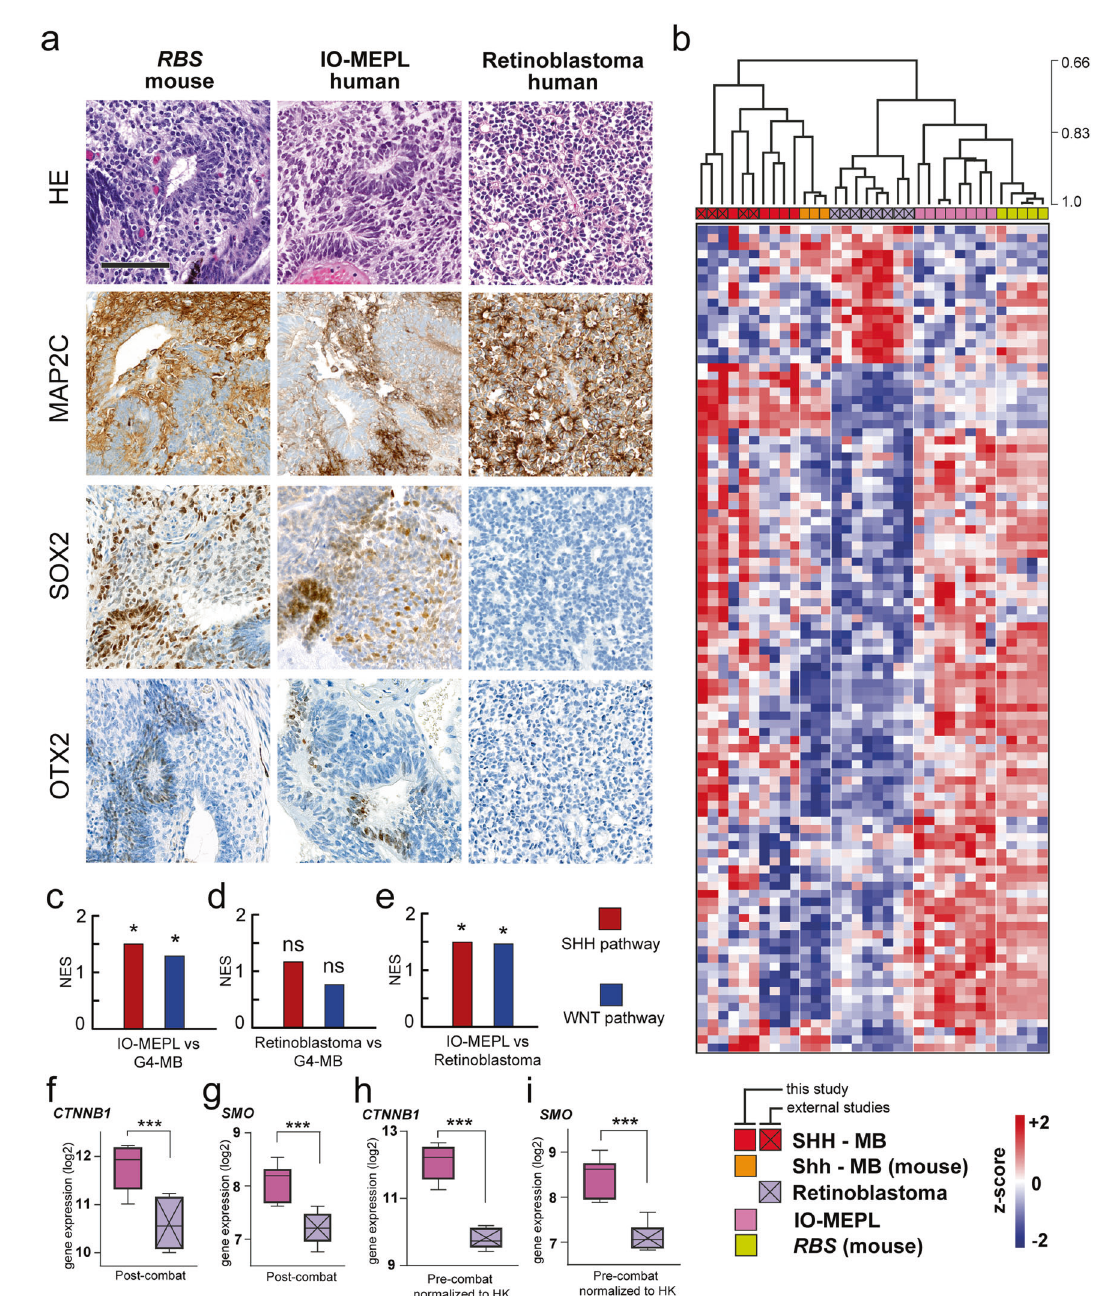
M. Dottermusch et Fig. 5 Rax - creER T2 ::Ctnnb1(ex3) fl / + SmoM2 fl / + ( RBS ) ocular lesions display molecular similarities to human IO-MEPL. a Both Shh and Wnt pathway genes were overrepresented in RBS ocular lesions in comparison to control eyes. GSEA was performed based on prede fi ned Nanostring gene sets. b Functional gene ontology (GO) term network of upregulated genes in RBS lesions compared to control eyes. Each node represents a signi fi cant GO term. Node colors indicate af fi liation of GO terms to GO groups. Node clusters are annotated with the top three most signi fi cant words of the respective GO term aggregation. Font size differences within the annotation of a distinct cluster represent varying signi fi cances. Edges indicate term – term inter-relations with Kappa score >0.3. Upregulated genes were determined by Welch- corrected t test with adjusted Bonferroni correction. c LC-MS/MS protein levels of genes identi fi ed as signi fi cantly upregulated in RBS E8.5 vs. control eyes. d Agreement of differential expression (AGDEX) revealed signi fi cant agreement of RBS lesions and human IO-MEPLs. Mouse Shh- MBs and human SHH-MBs were taken as a reference. Asterisk indicates signi fi cance: p value <0.05*. e Pearson correlation analysis based on cross-species harmonized gene expression data showed highest correlation of RBS lesions with human IO-MEPL and highest correlation of mouse Shh-MBs with human SHH-MBs. f Hierarchical clustering (based on Pearson correlation) based on cross-species harmonized gene expression data. Ocular lesions in RBS mice formed a distinct cluster with human IO-MEPLs. Established Shh-MBs from 14-day-old hGFAP-cre:: SmoM2 fl / + mice, which formed a distinct cluster together with SHH-MBs served as a reference control. Analysis incorporated the top 60% of genes with highest variance. g Principal component analysis (PCA) plots based on cross-species harmonized gene expression data showed species-independent grouping of samples. Analysis incorporated the top 60% of genes with highest variance. Cross-species gene expression analysis was based on 718 common genes of the human and mouse PanCancer pathways panels (Nanostring Technologies).